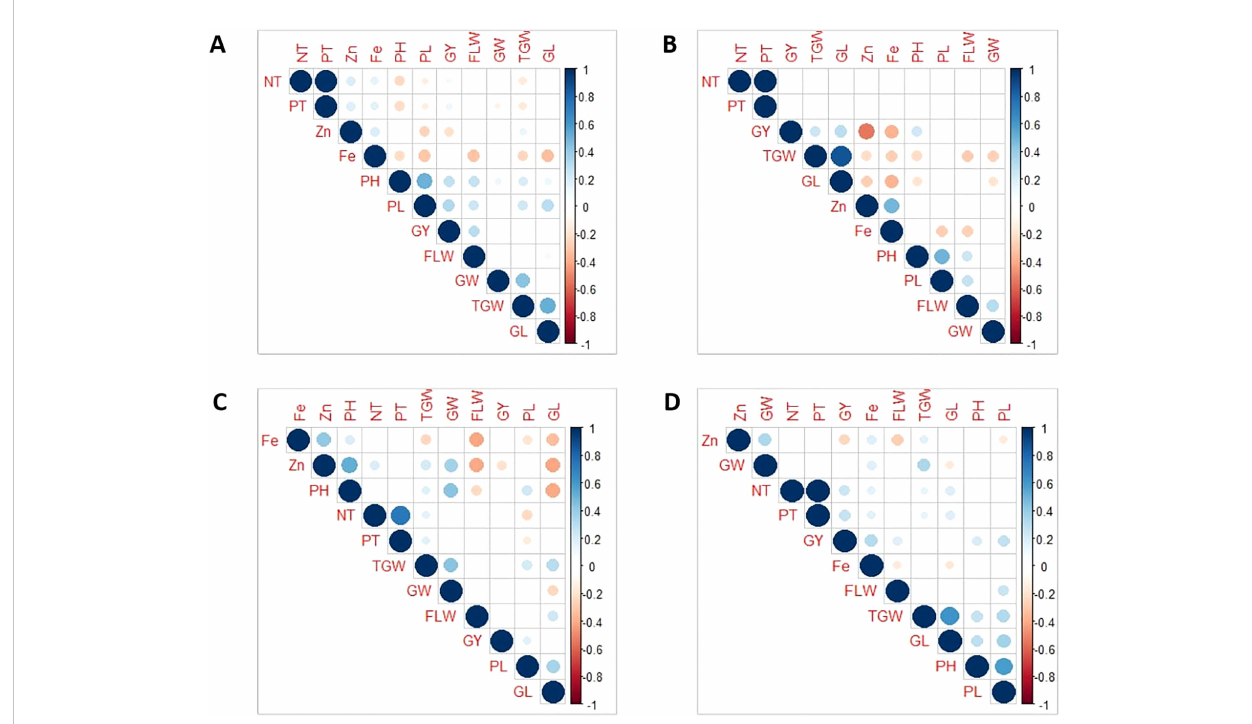
FIGURE 1 Pearson ’ s correlation coef fi cients of 11 traits in four connected populations: Pop1 (A) , Pop2 (B) , Pop3 (C) , and Pop4 (D) . GY, Grain Yield; DF/FLW, Days to fl owering; PH, Plant Height; NT, Number of Tillers; PT, Productive Tillers; PL, Panicle Length; TGW, Total Grain Weight; GL, grain length; GW, Grain